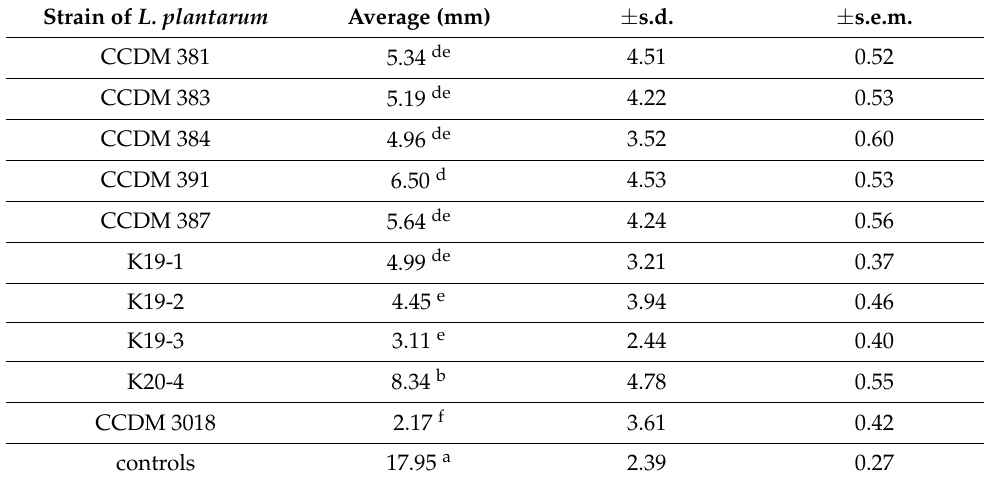
Table A3. Cont. Strain of L. plantarum Average (mm)